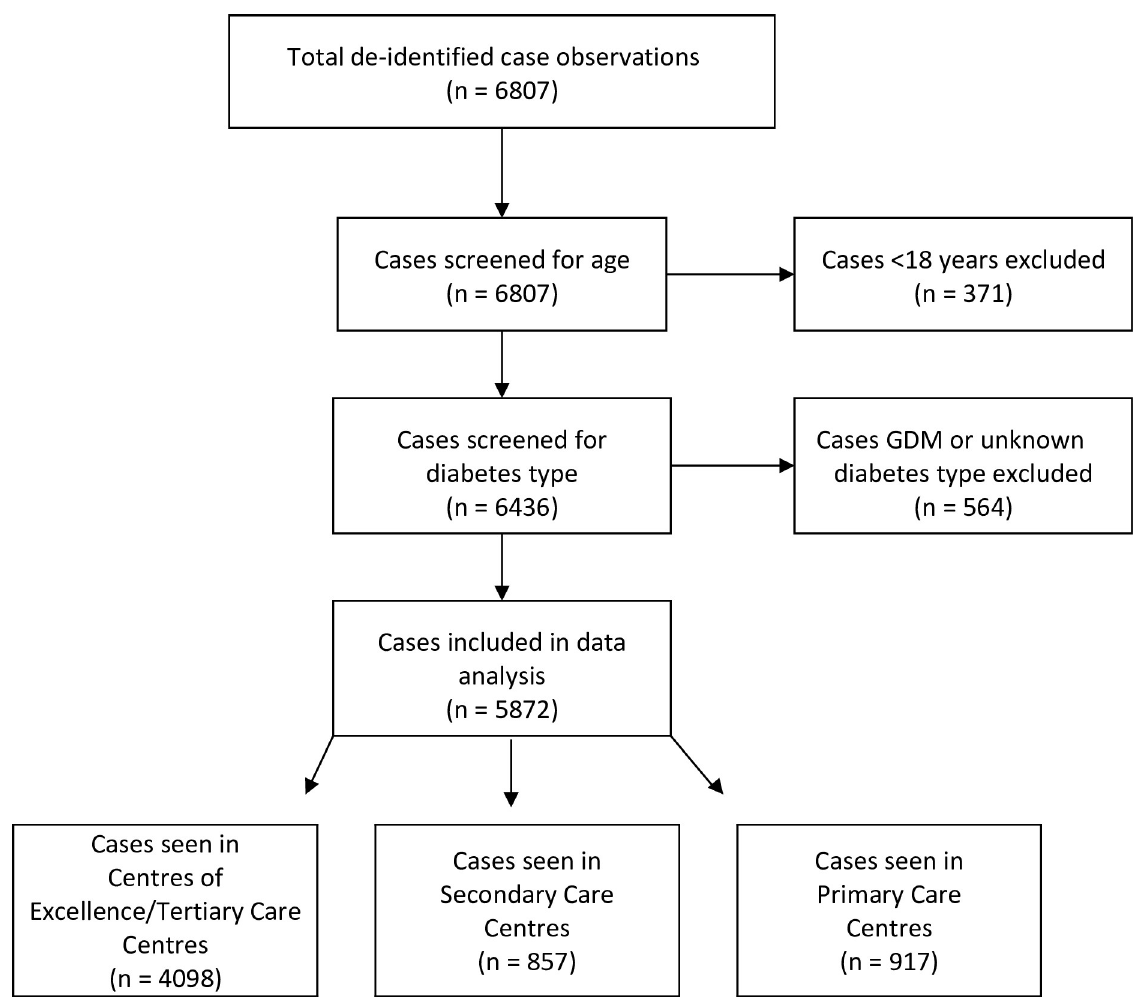
Fig 1. Inclusion flow diagram. Total de-identified case observations are shown, with screening and reasons for exclusion. Data included in the analyses are shown as per the treating diabetes centre